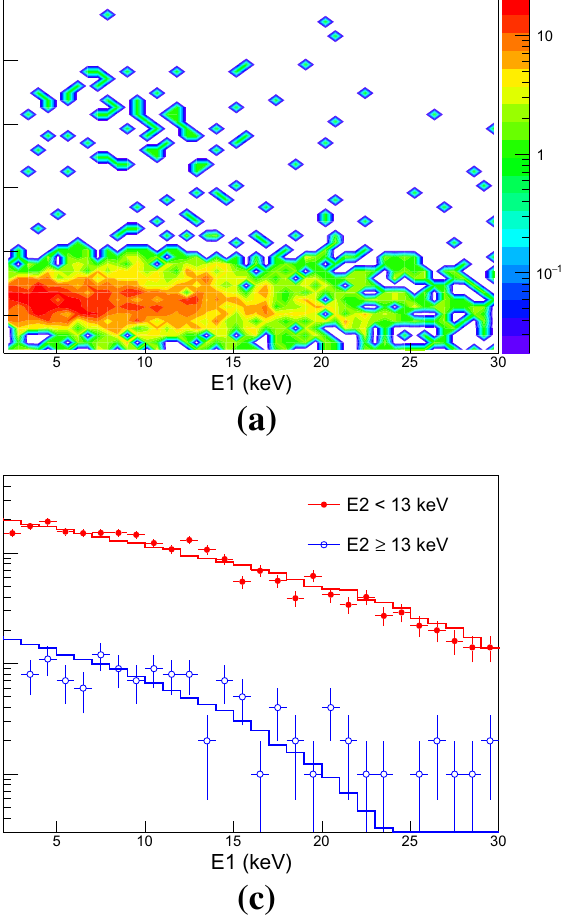
Geant4-based simulation of β spectra with Q = 39.52keV (red solid line) and Q = 25.61keV (blue solid line). ( d ) The distribution of the two-pulse time difference, (cid:6) T, for E2 < 13keV (red filled circles) and E2 ≥ 13keV (blue opened circles). Exponential fits (solid lines) to obtain the lifetimes are